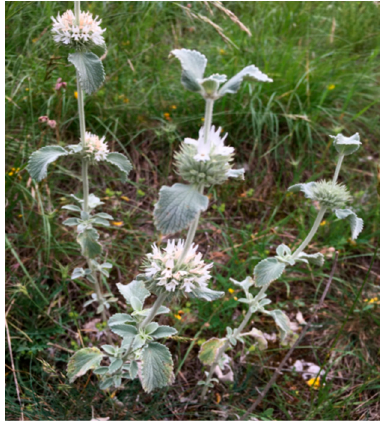
Figure 1. Marrubium incanum Desr.